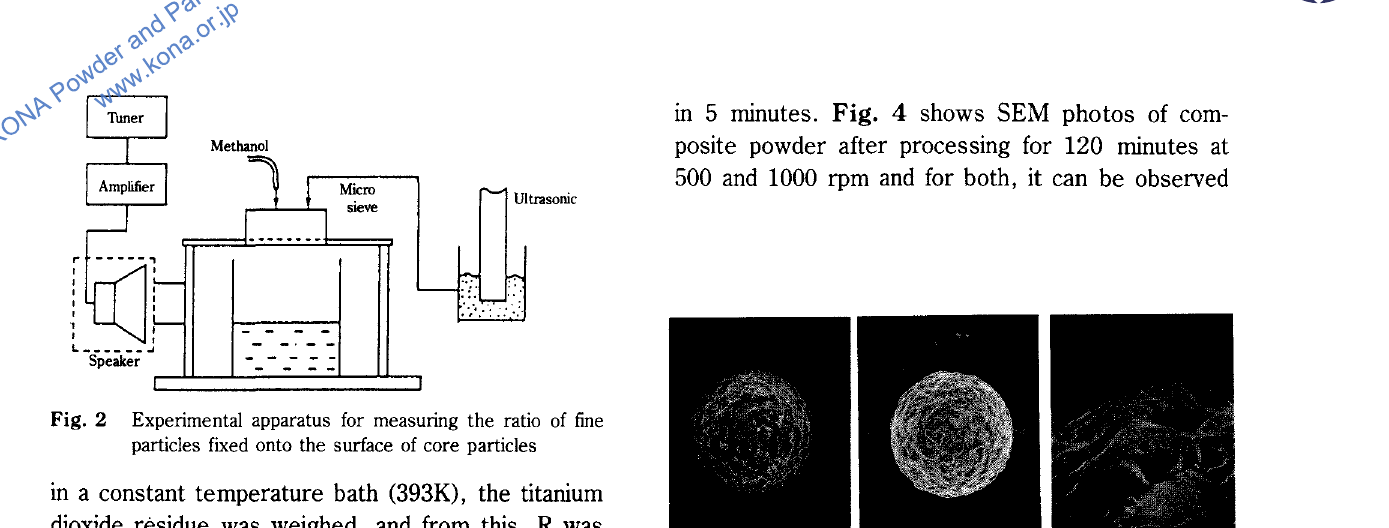
Fig. 4 SEM pictures of glass beads-Ti0 2 composite particles (a) N = 500 r.p.m., 120 min process, (b) (c) N = 1000 r. p.m., 120 min